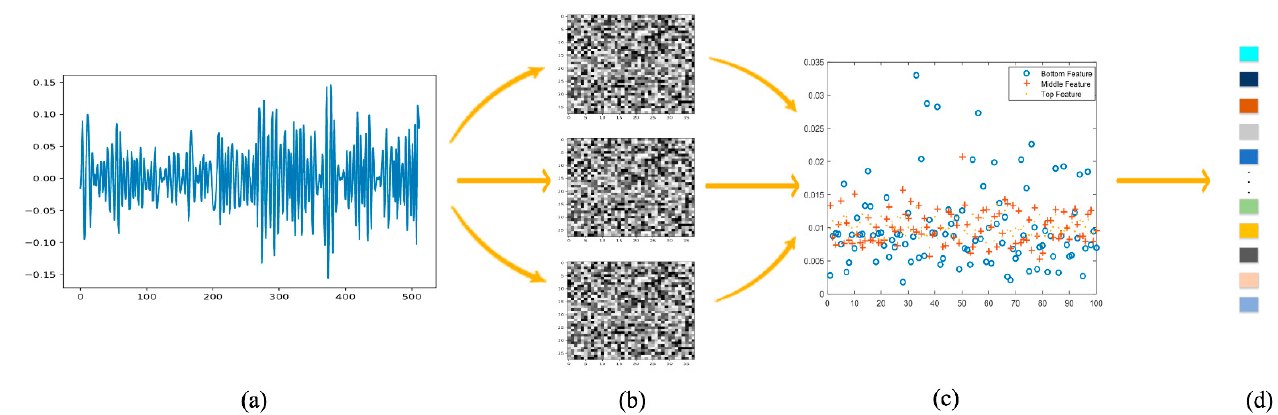
Figure 5. Feature extraction schematic: ( a ) original signal; ( b ) convolution kernel; ( c ) distribution scatterplot of the three-layer features; ( d ) new high-dimensional feature. Next, we extracted the features and obtained feature scatterplots for the EEG signals of nine different emotions (Figure 6). The features extracted from our model exhibited better separability than those of the other models.